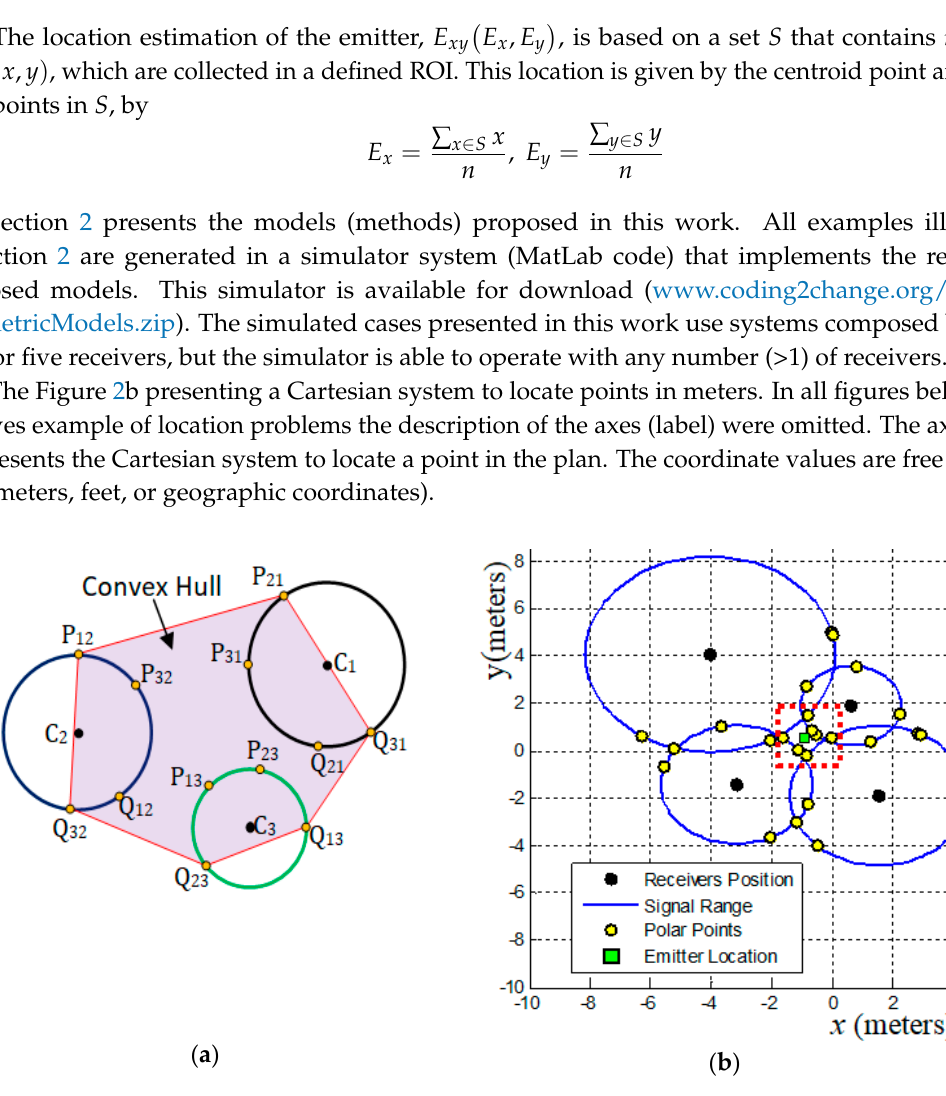
Figure 2. ( a ) Illustration of Convex Hull algorithm applied to a set of polar-points. ( b ) An example of signal data and it respective signal ranges with its polar points. This case represents sets of signal data with satisfactory quality. The red dotted rectangle mark a region where a set of polar points enveloping the location of an emitter device.